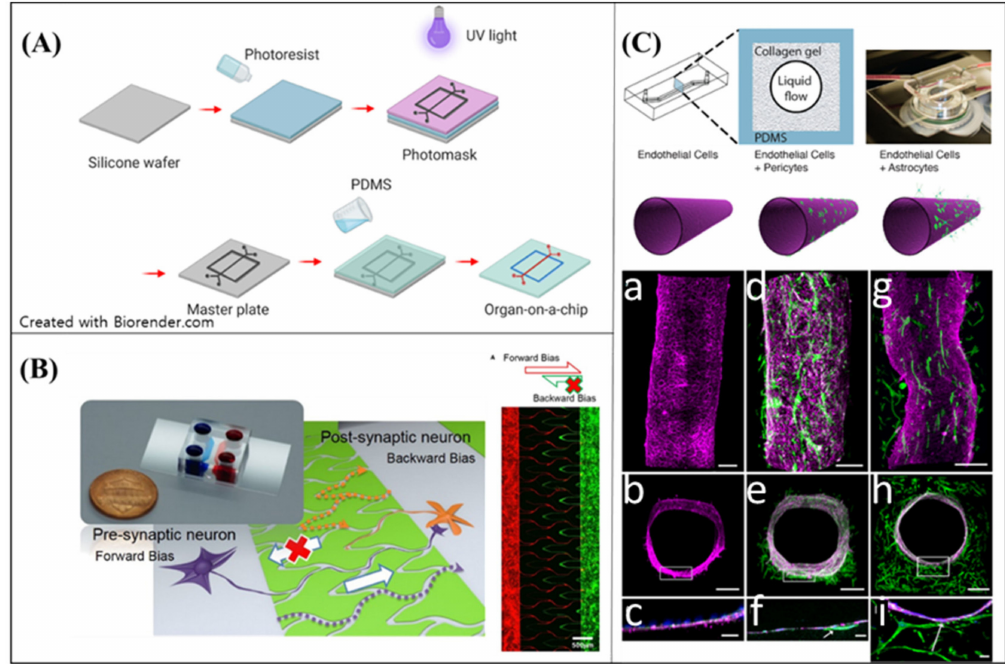
Figure 5. Soft lithography based neural MPS ( A ) Schematic of the soft-lithography progress for organ-on-a-chip ( B ) Neural diode on microfluid controlled model. Reproduced with permission from [110] ( C ) Microfluidic-based blood-brain barrier(BBB) model. Reproduced with permission from